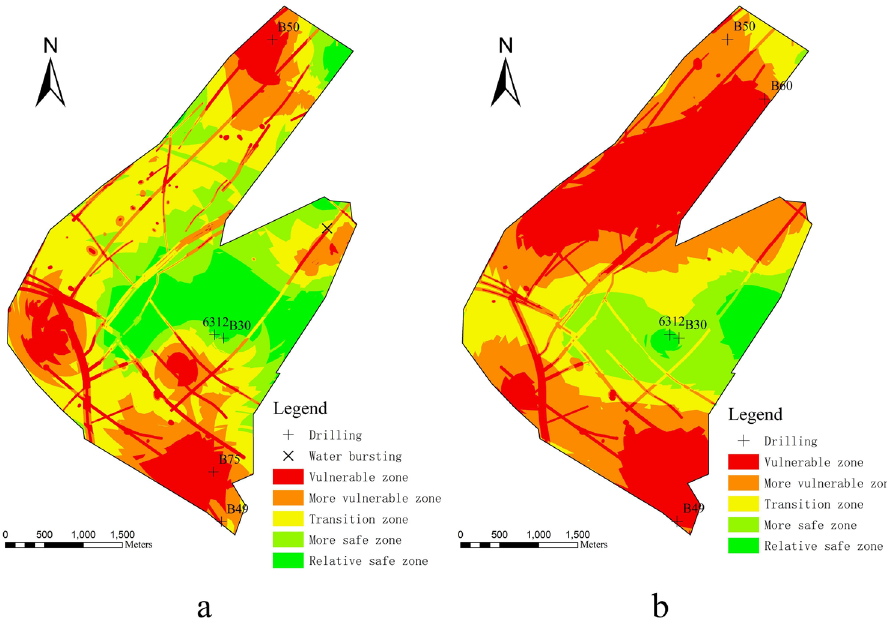
Figure 4. Map of water bursting evaluation results: ( a ) Ordovician limestone aquifer; ( b ) Benxi limestone aquifer. Images are created using the ArcGis, https:// www. esri. com/ en- us/ arcgis/ produ cts/